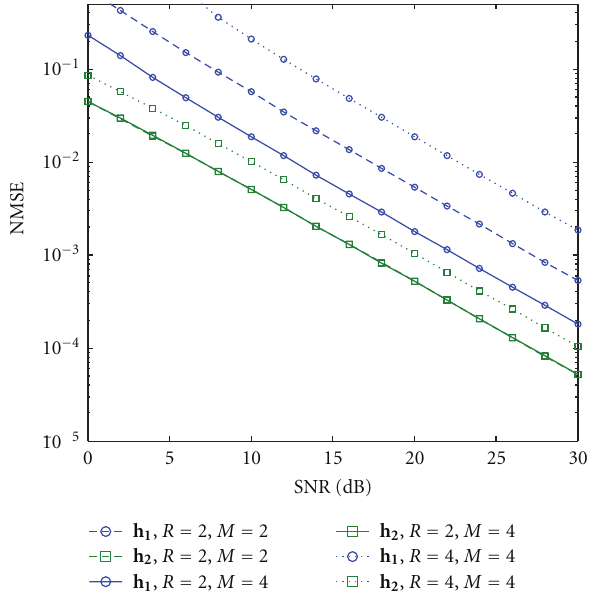
Figure 7: Channel estimation NMSEs versus R and M for α = 0.5.